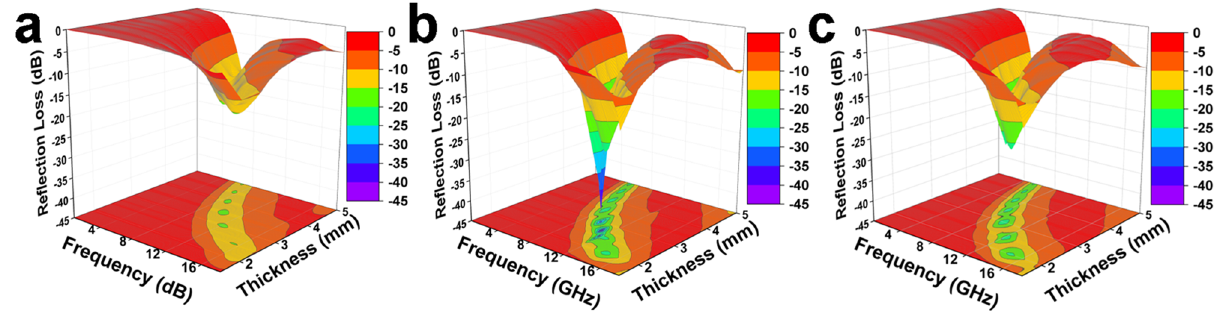
Figure 6: RL curves of McM@rGO at di ff erent thicknesses ( 1.5 – 5.0 mm ) from 2.0 to 18.0 GHz: ( a ) McM@rGO - 400, ( b ) McM@rGO - 600, and (